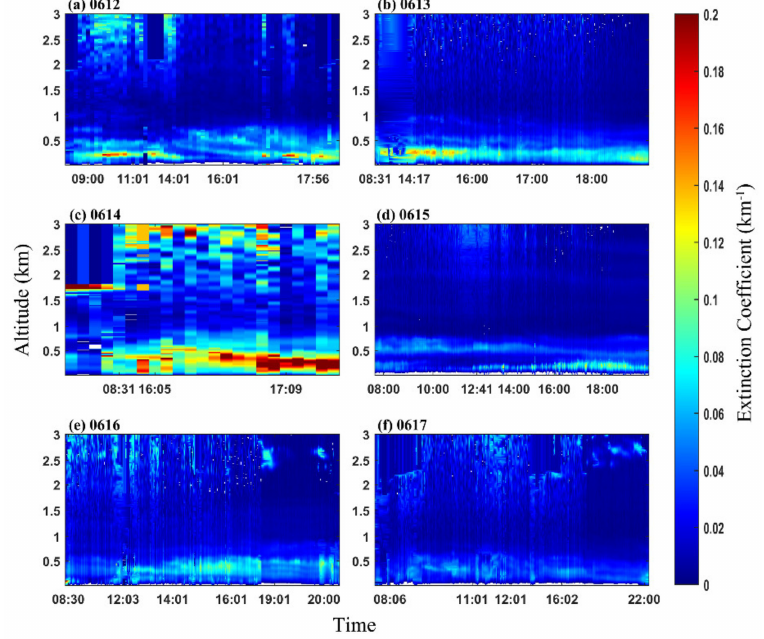
Figure 10. The cross sections of the extinction coefficient from 12 June to 17 June